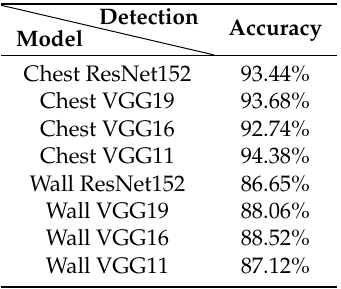
Table 2. Classifier accuracy for models of different complexities; seven actions.